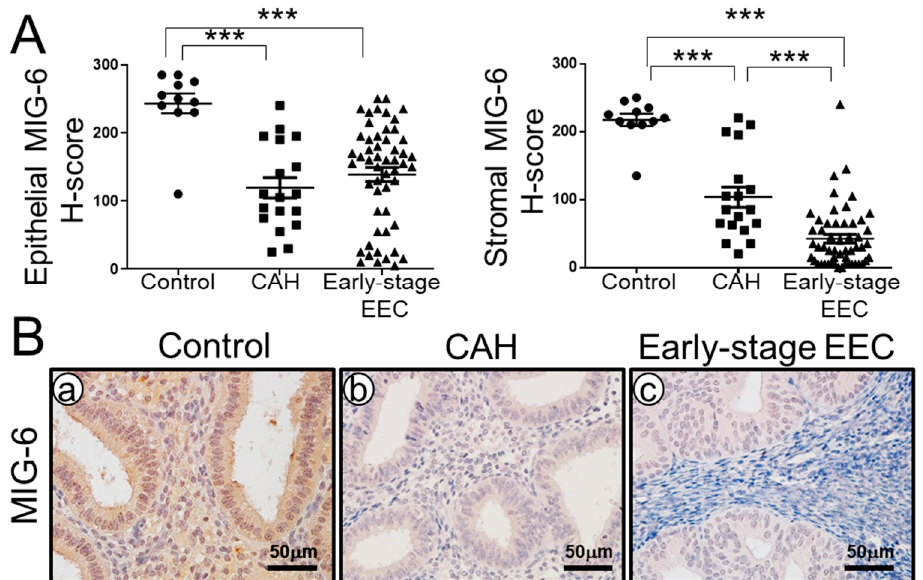
Figure 1. MIG-6 is downregulated in CAH and early-stage EEC. ( A ) H-score of MIG-6 showed that the MIG-6 expression is significantly lower in CAH (n = 18) and early stage (I and II) of EEC (n = 53) compared to control (n = 11). ( B ) Representative MIG-6 expression in control (a), CAH (b), and Early- Stage EEC (c) by immunohistochemistry. ***, p < 0.001. Early-Stage EEC ( c ) by immunohistochemistry. *** p <